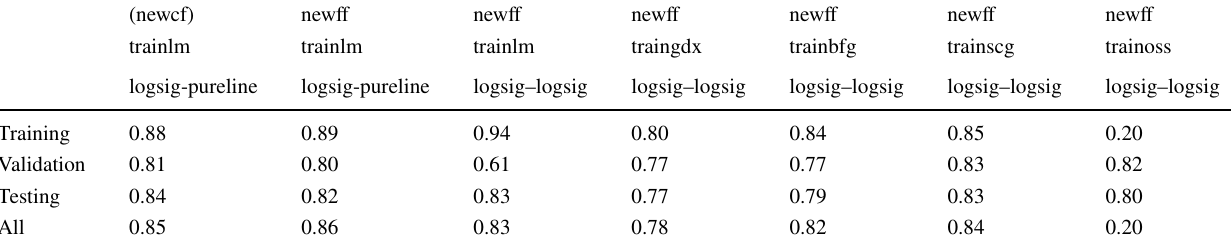
Table 7 The effect of the neurons number combination for type 2